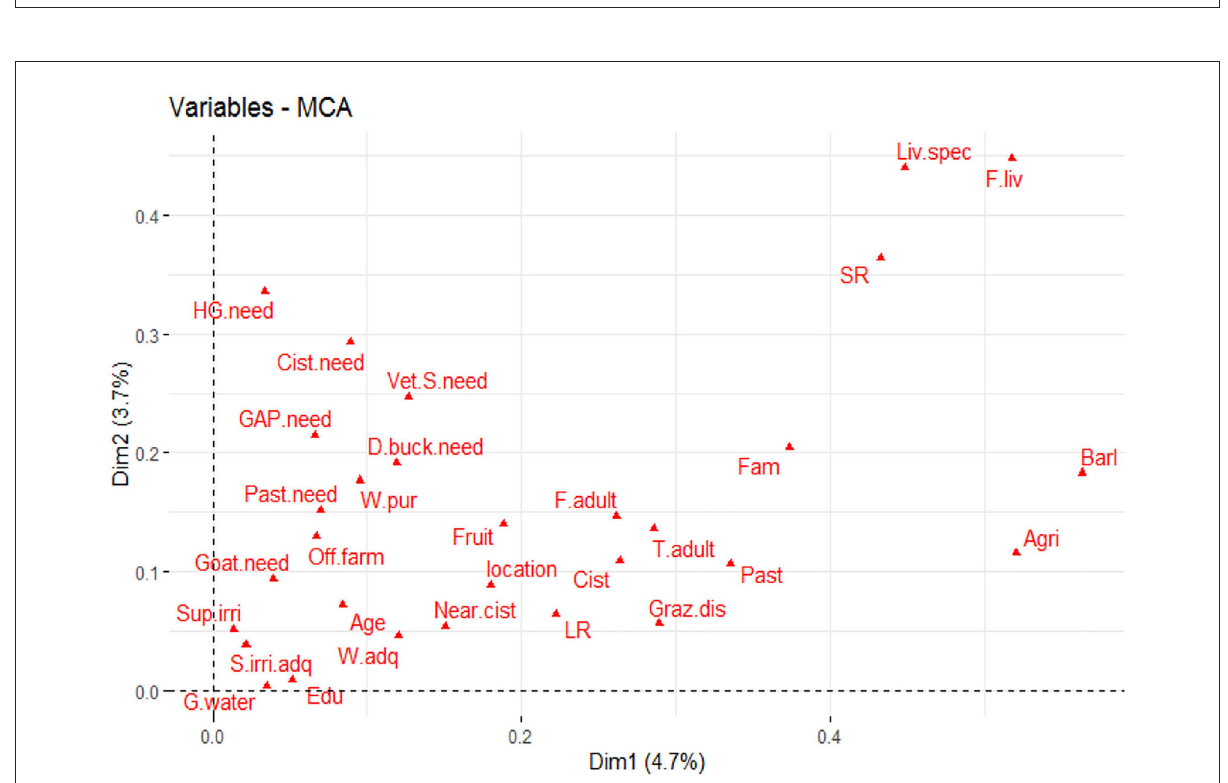
FIGURE4 Mapping of the main variables for the